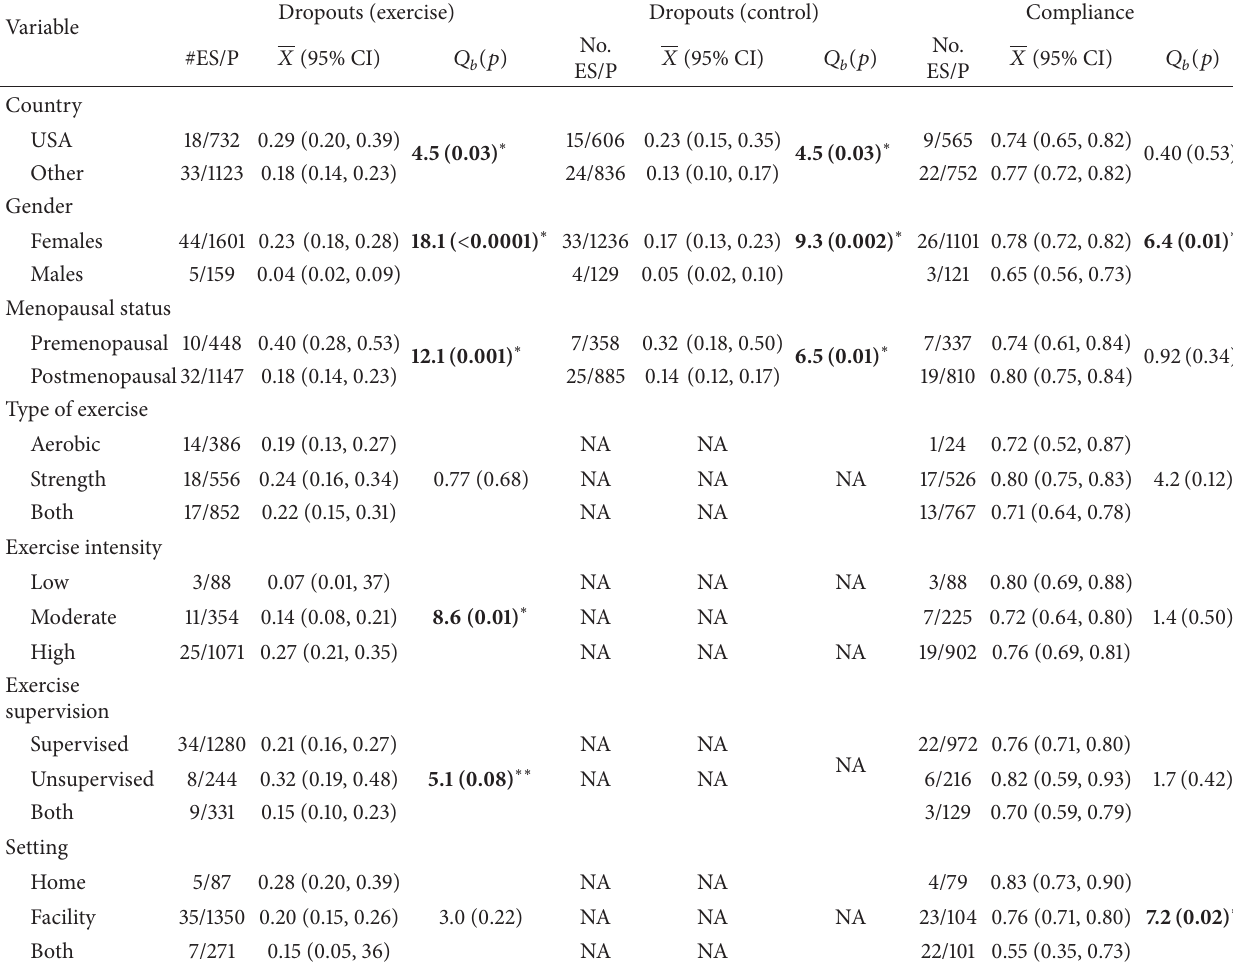
Table 2: Moderator analyses (mixed effects) for dropouts and